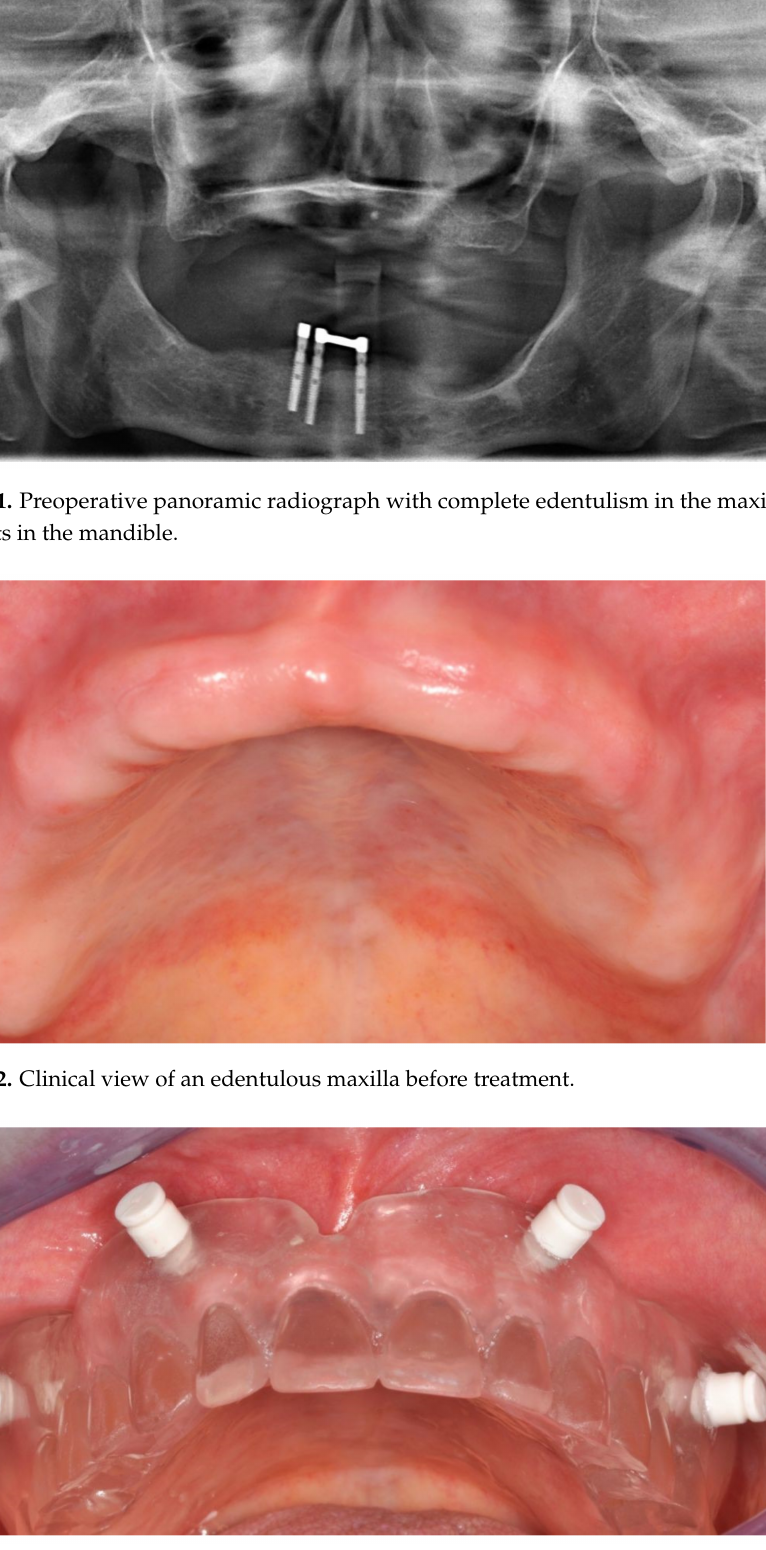
Figure 3. Radiographic template with radiopaque landmarks made from a duplicate of the